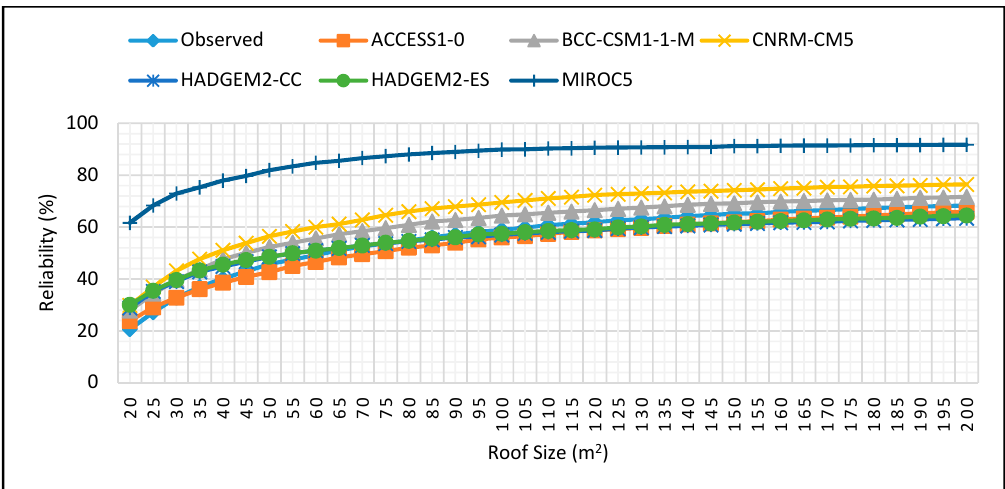
Figure 21. Reliability projections for JJA season for 1 m 3 tank size for 2060–2090 period.